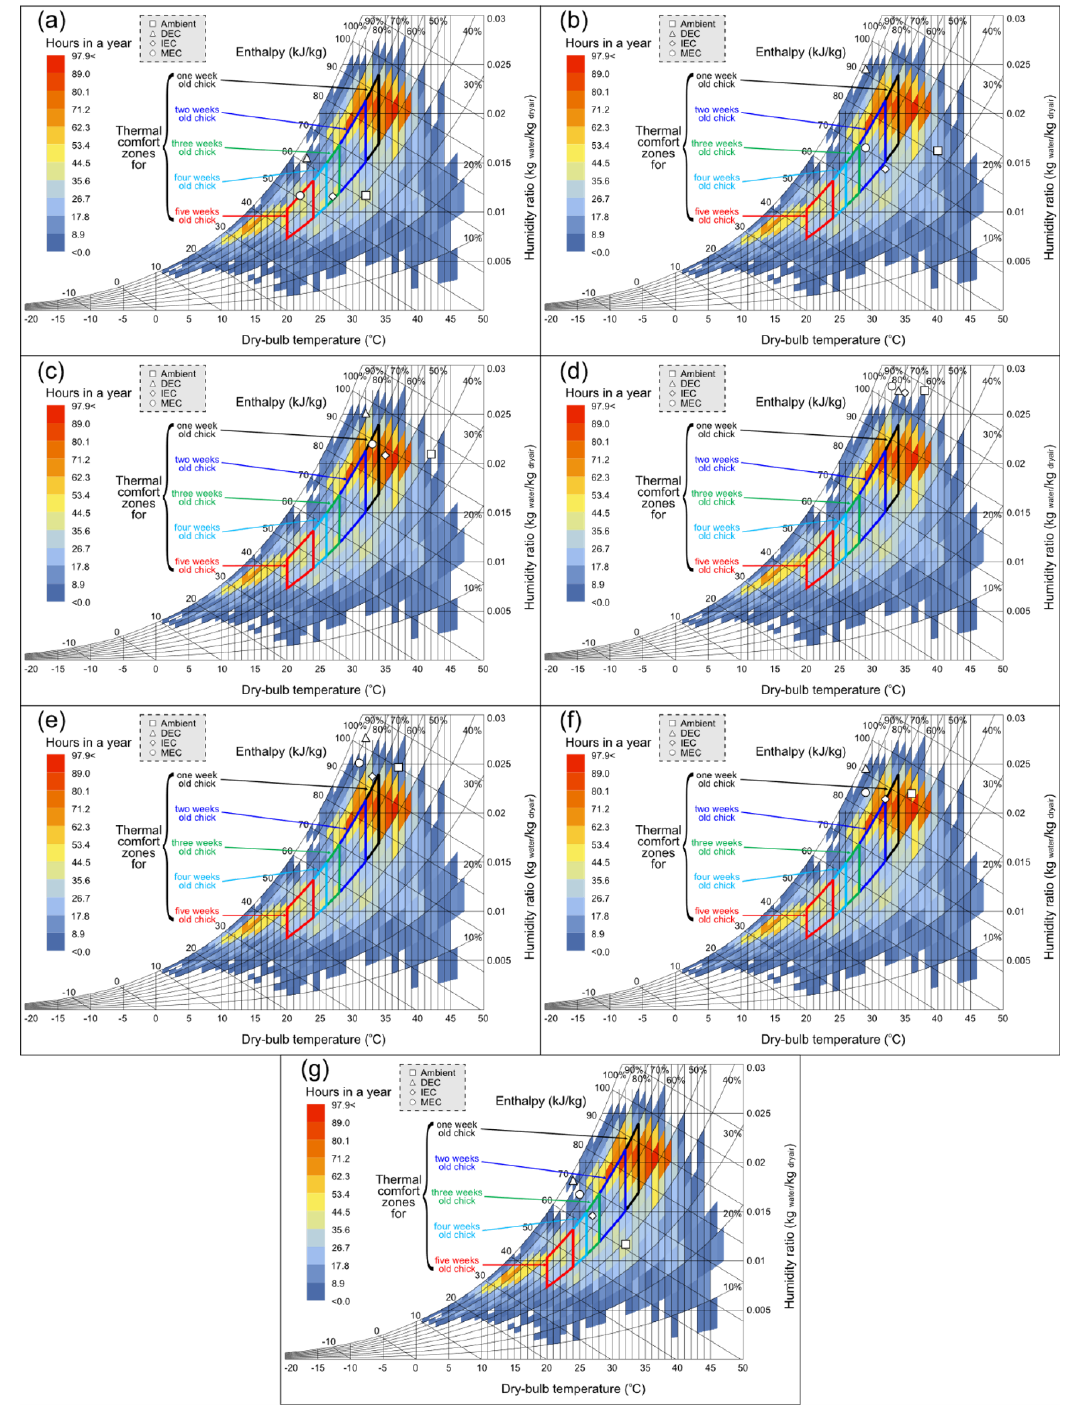
Figure A2. Psychrometric representation of the performances of EC systems for the months of ( a ) April, ( b ) May, ( c ) June, ( d ) July, ( e ) August, ( f ) September, and ( g ) October.